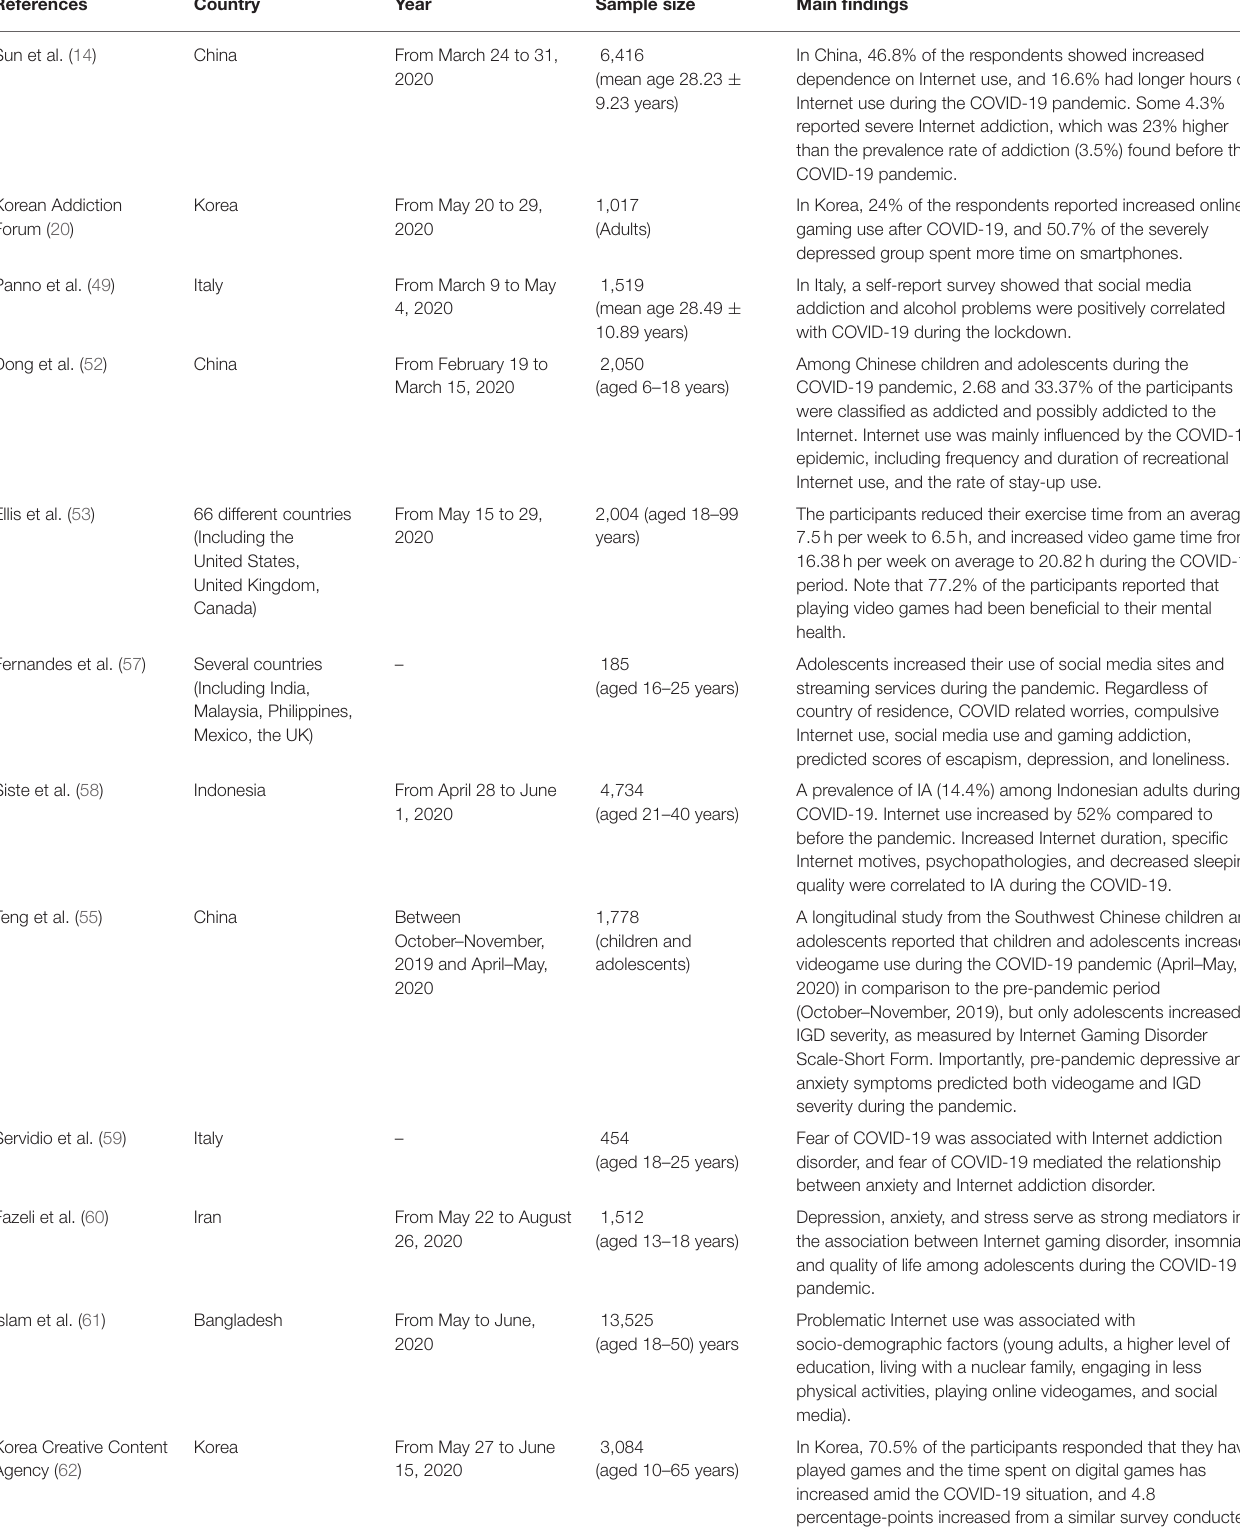
TABLE 2 | Literature review of online gaming use during the COVID-19